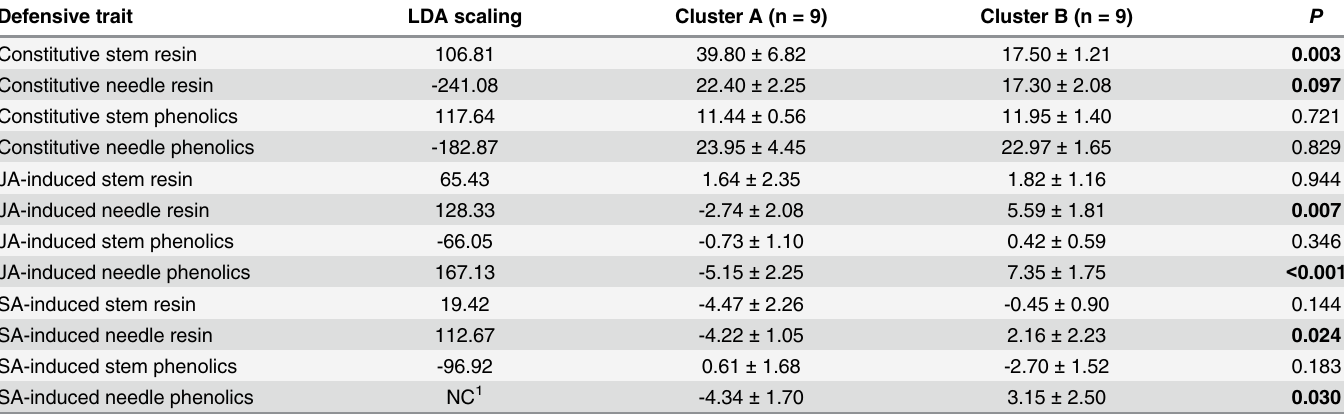
Table 1. Contribution of the studied pine constitutive defensive traits and their inducibility to the defensive clustering of pine species. Trait values (least square mean ± SE) for the two defensive clusters (syndromes) and coefficients for linear discriminant analyses (LDA scaling) are shown. Significant ( P < 0.05) and marginal ( P < 0.10) differences between clusters are typed in bold.